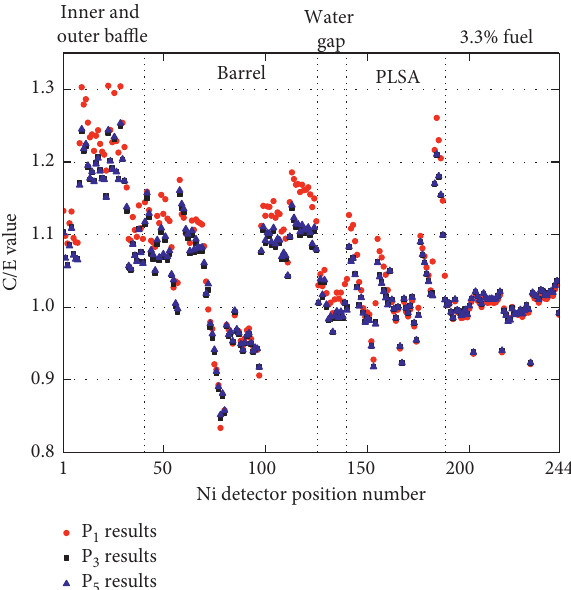
Figure 14: Comparison of Legendre expansion order of the 58 Ni(n,p) 58 Co